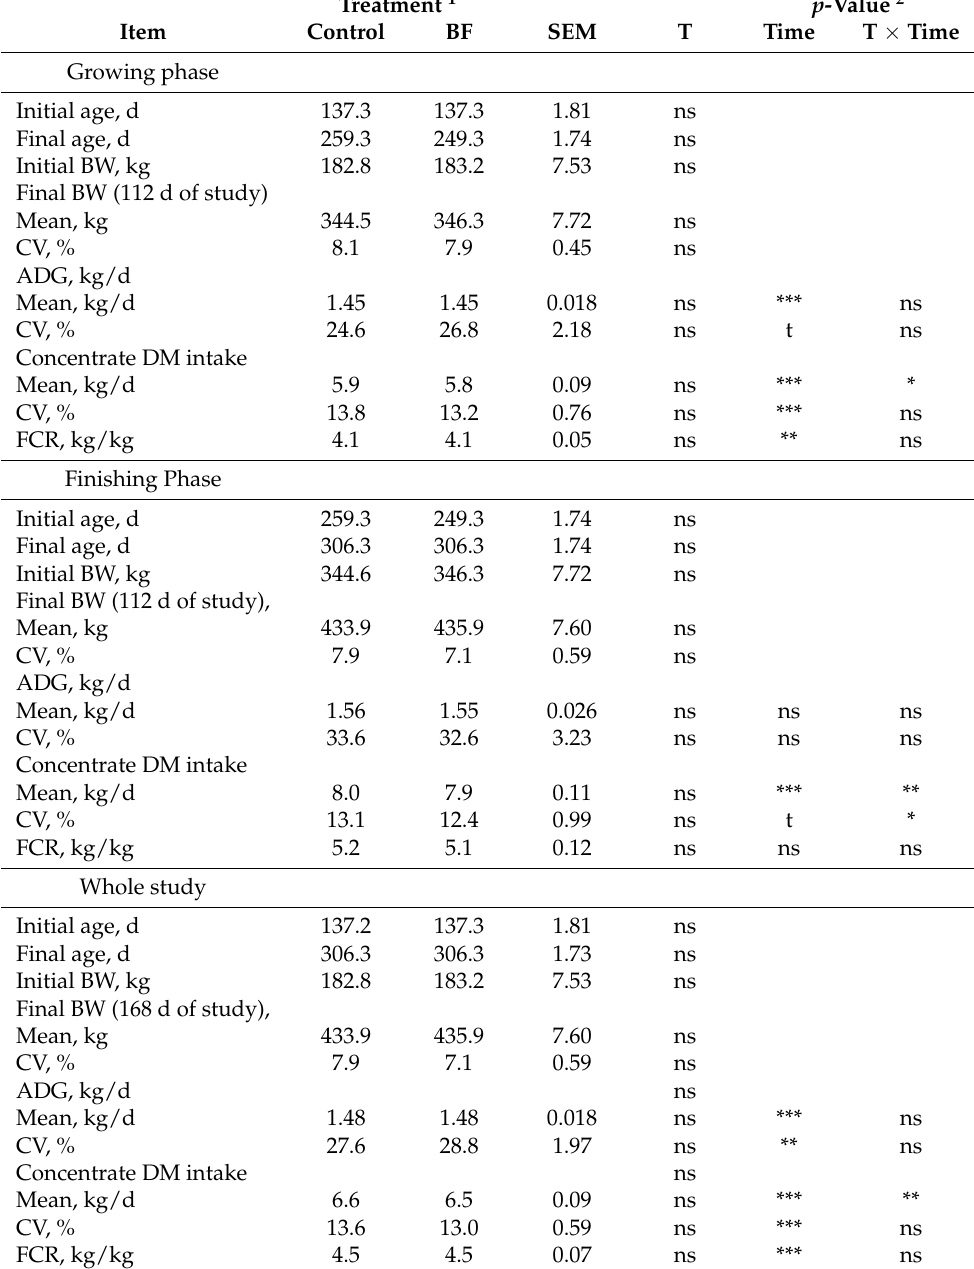
Table 2. Performance and concentrate intake for growing and finishing phases, and for the whole study in Holstein bulls fed high-concentrate diets supplemented with citrus